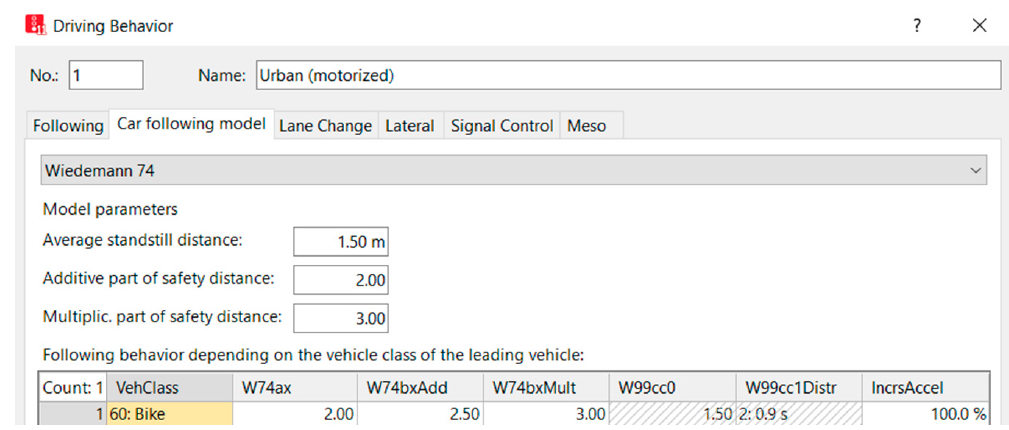
Figure 6. Adapted car following model for cars.